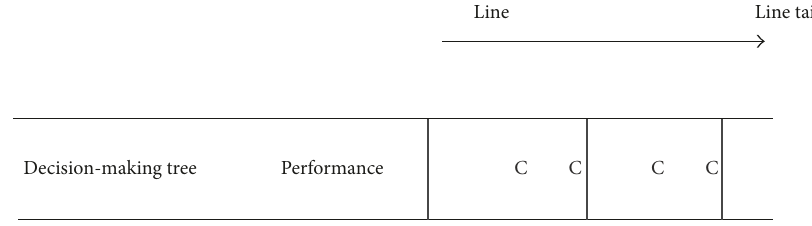
Figure 1: Transmission model for outlier-data-carrying decision-tree information chain under mobile Internet conditions.